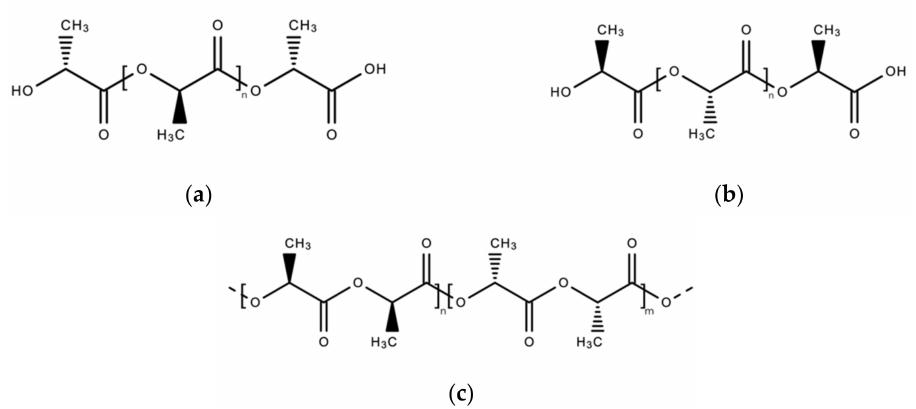
Figure 13. ( a ) PDLA, ( b ) PLLA, and ( c ) PDLLA, where n and m are integers of the repetition